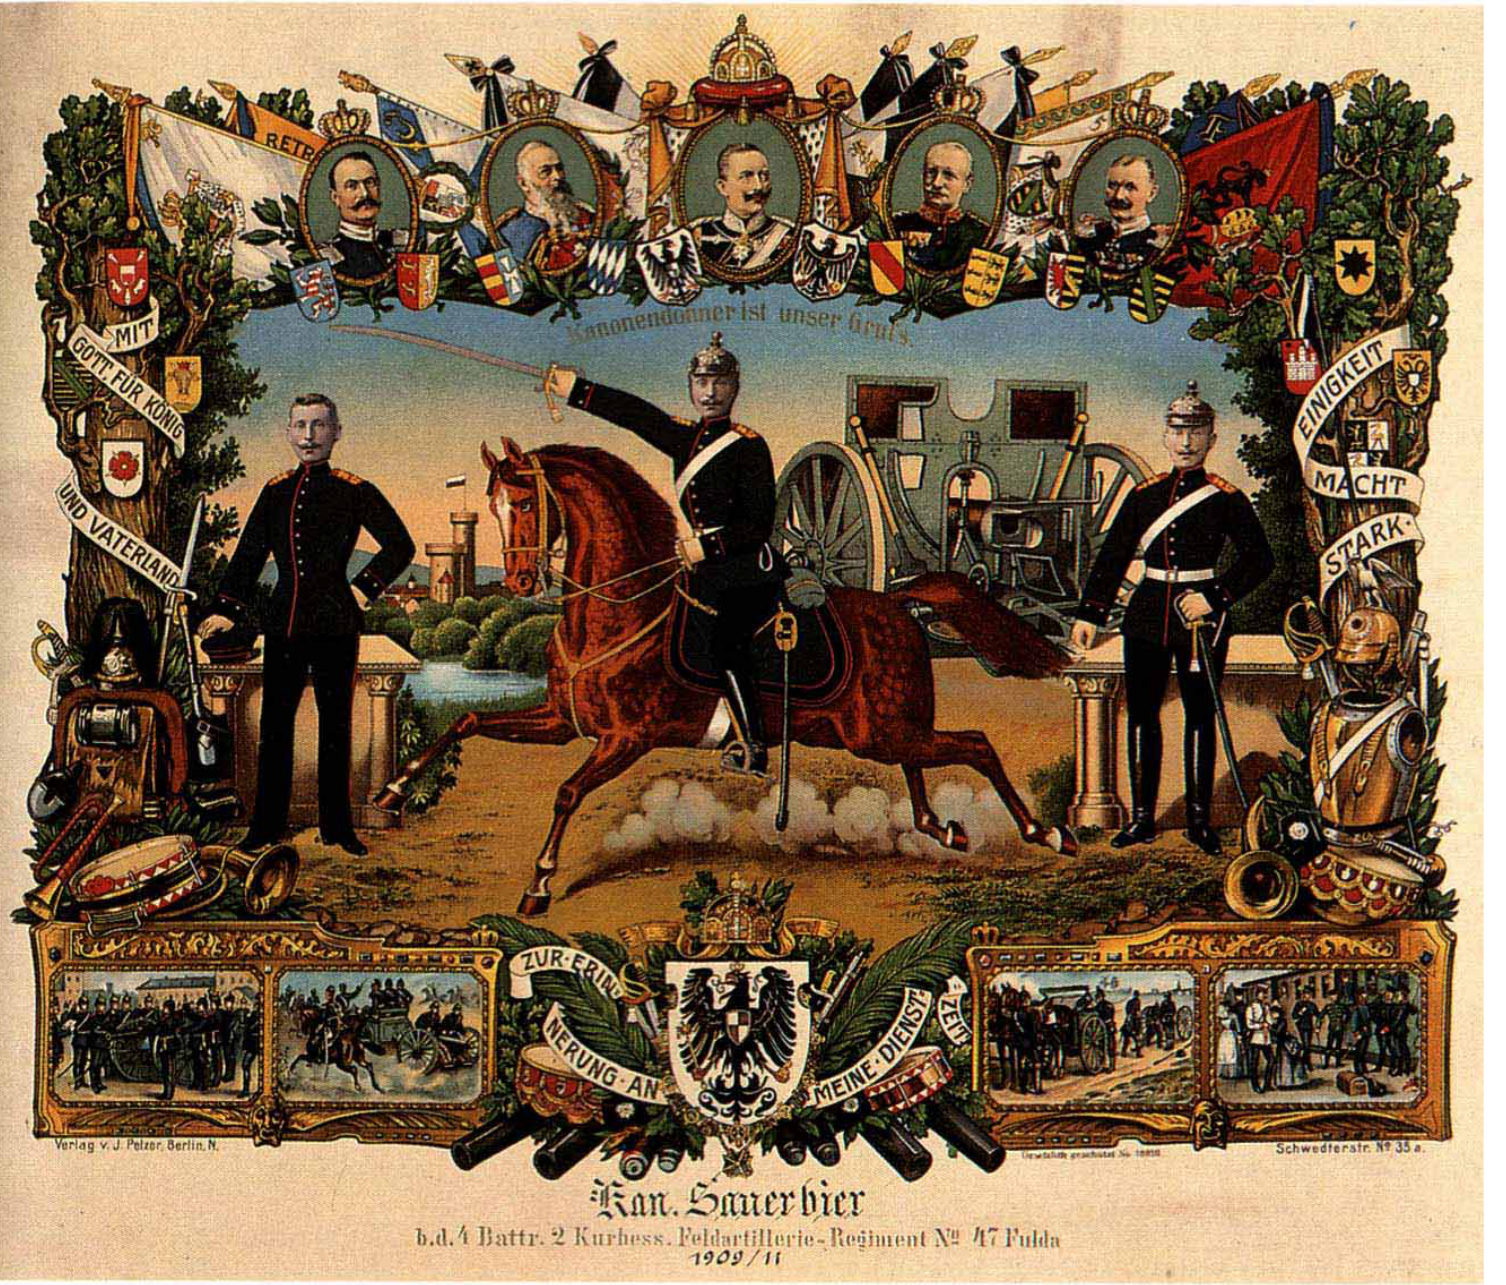
Figure 2 Unknown photographer and Verlag v. J. Petzer, Berlin, Kanonier Sauerbier bei der 4. Batterie, 2. Kurhessisches Feld-Artillerie-Regiment Nr. 47, Fulda (Cannoneer Sauerbier of the 4 th Battery, 2 nd Kurhessische Field Artillery Regiment, Nr. 47, Fulda). 1911. Multicolored lithograph with collaged photographs. Collection of the Museum Folkwang, Essen. 45 x 57